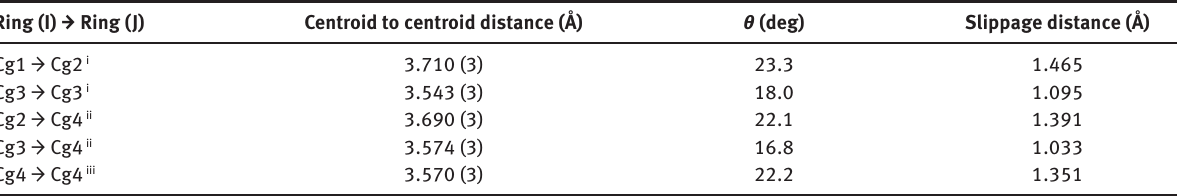
Table 3: π–π interactions for the compound